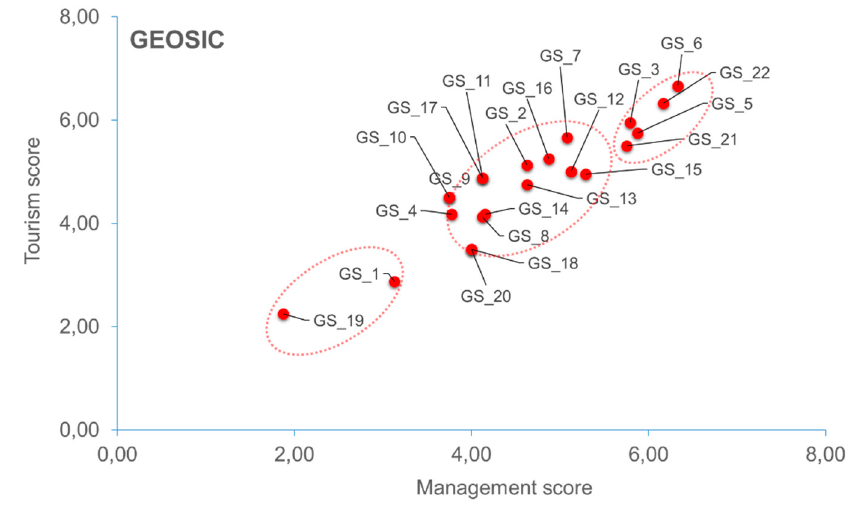
Figure 10. Clustering of the 22 geosites in the Sicily study area.